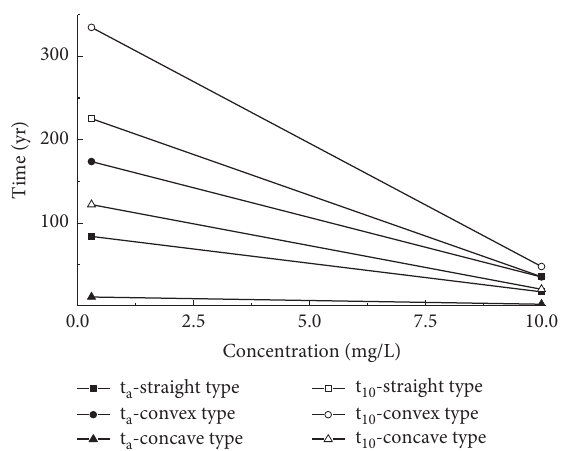
Figure 7: Effect of breakthrough time of different